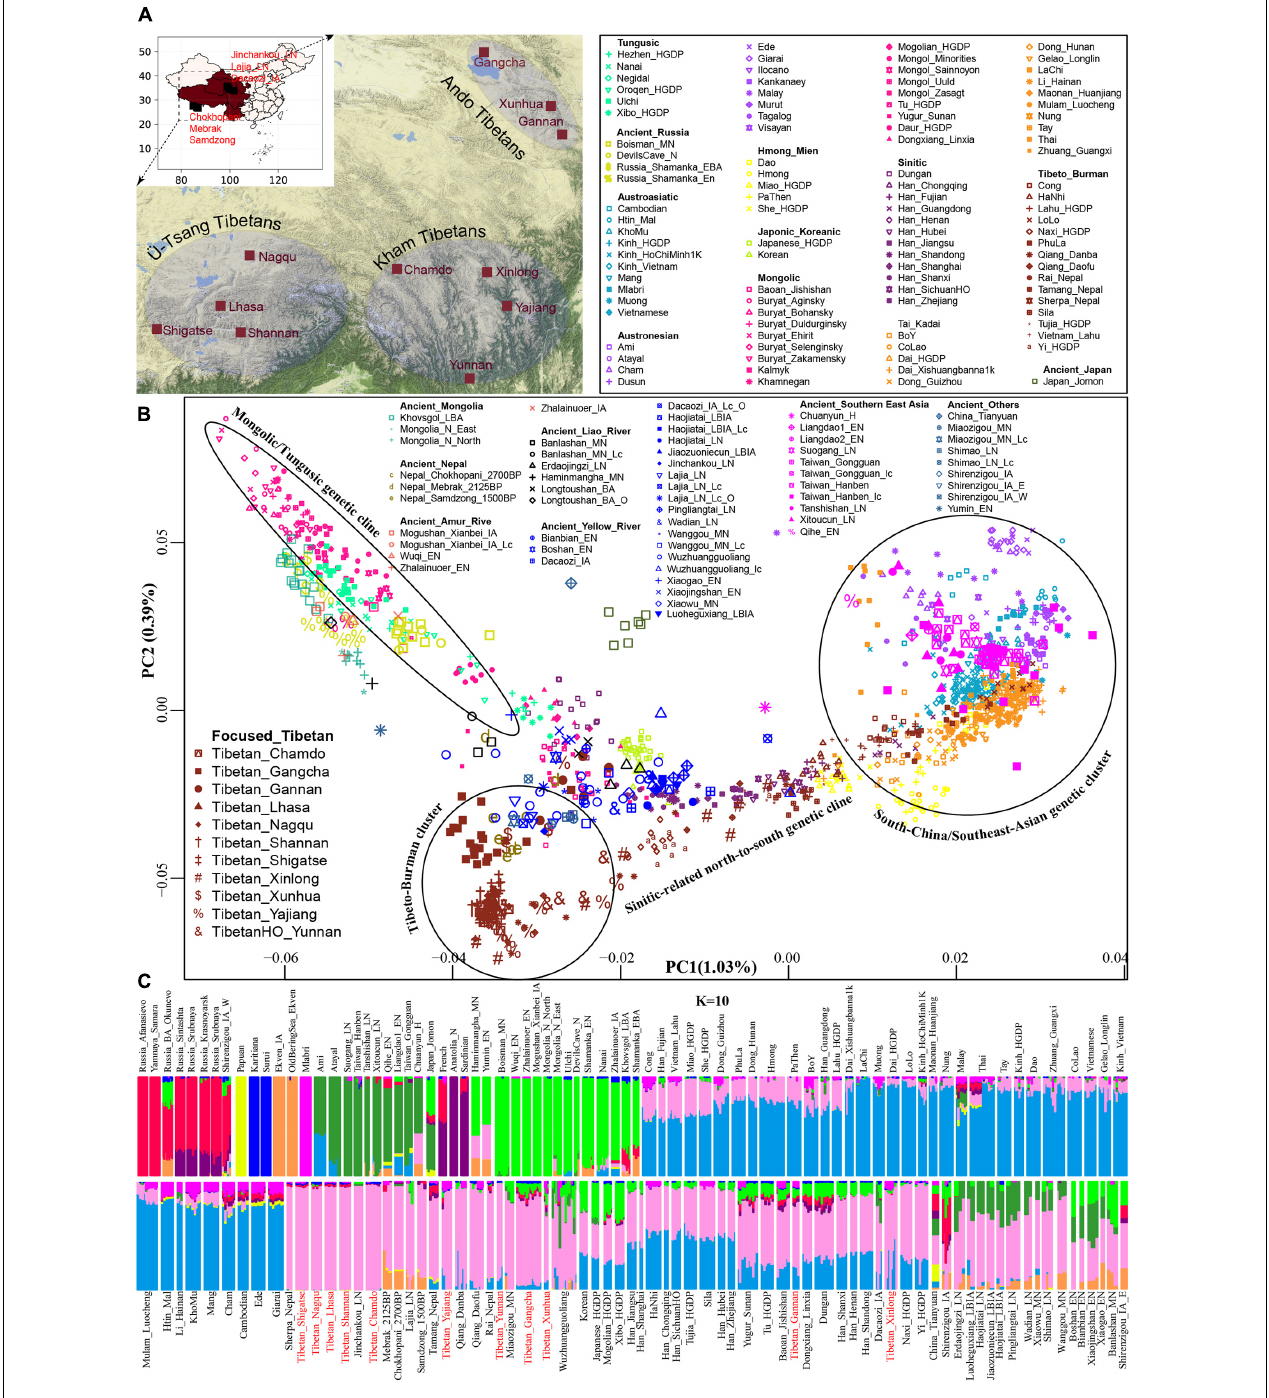
FIGURE 1 | The geographical position of the focused Tibetans and genetic patterns of East Asians. (A) Sampling place of eleven geographically different modern Tibetan populations mainly discussed in the present study from the five provinces (Tibet Tibetan Autonomous Region, Qinghai, Gansu, Sichuan, and Yunnan) from western China. China map is presented in the top-left of A and five studied western provinces were zoom-in as the presented Google map. (B) Principal component analysis (PCA) showed the genetic similarities and differences between the ancient/modern East Asians from geographically/linguistically/culturally different populations. Spatial-temporally diverse ancient populations were projected onto the two-dimensional genetic background of modern East Asians. (C) Admixture ancestry estimation based on the model-based ADMIXTURE. Here, the optimal predefined ten ancestral populations were used. EN, early Neolithic; MN, middle Neolithic; LN, late Neolithic; IA, iron age; BA, bronze Age; LBIA, late bronze age and iron age; Lc, loc coverage; O, outlier.